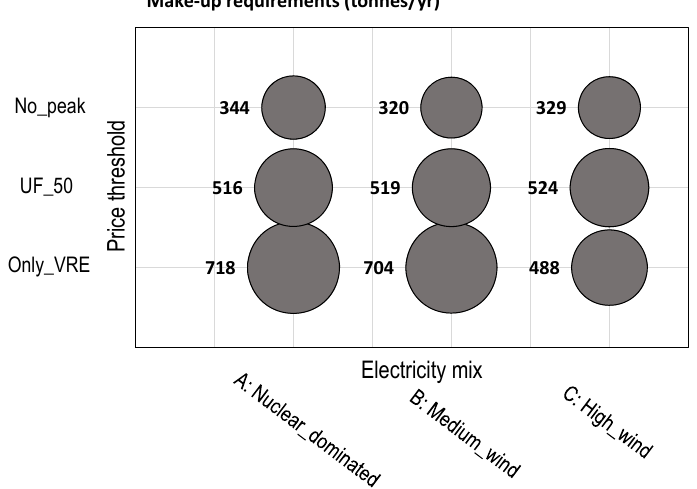
Figure 11. Make-up flow required for each of the nine scenarios under Figure 11. Make ‐ up flow required for each of the nine scenarios under investigation.